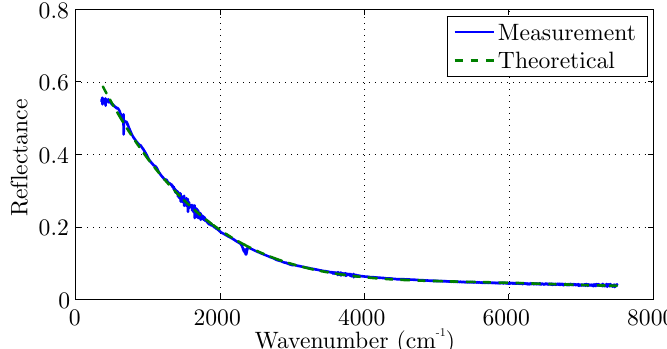
Figure 6. The measured versus the theoretical infrared spectrum of the ferrous base underneath the thin dielectric